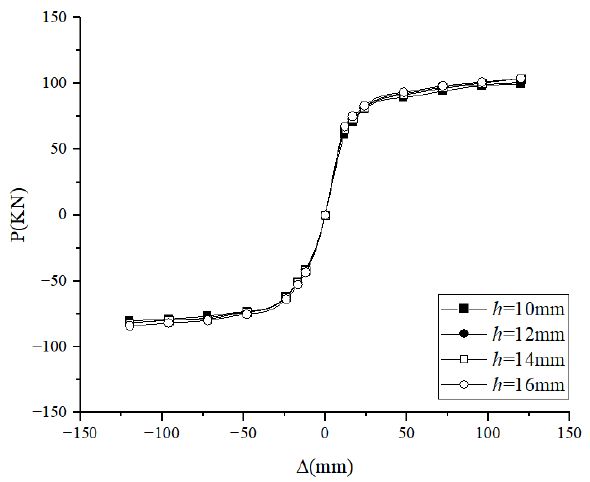
Figure 23. Thickness of internal